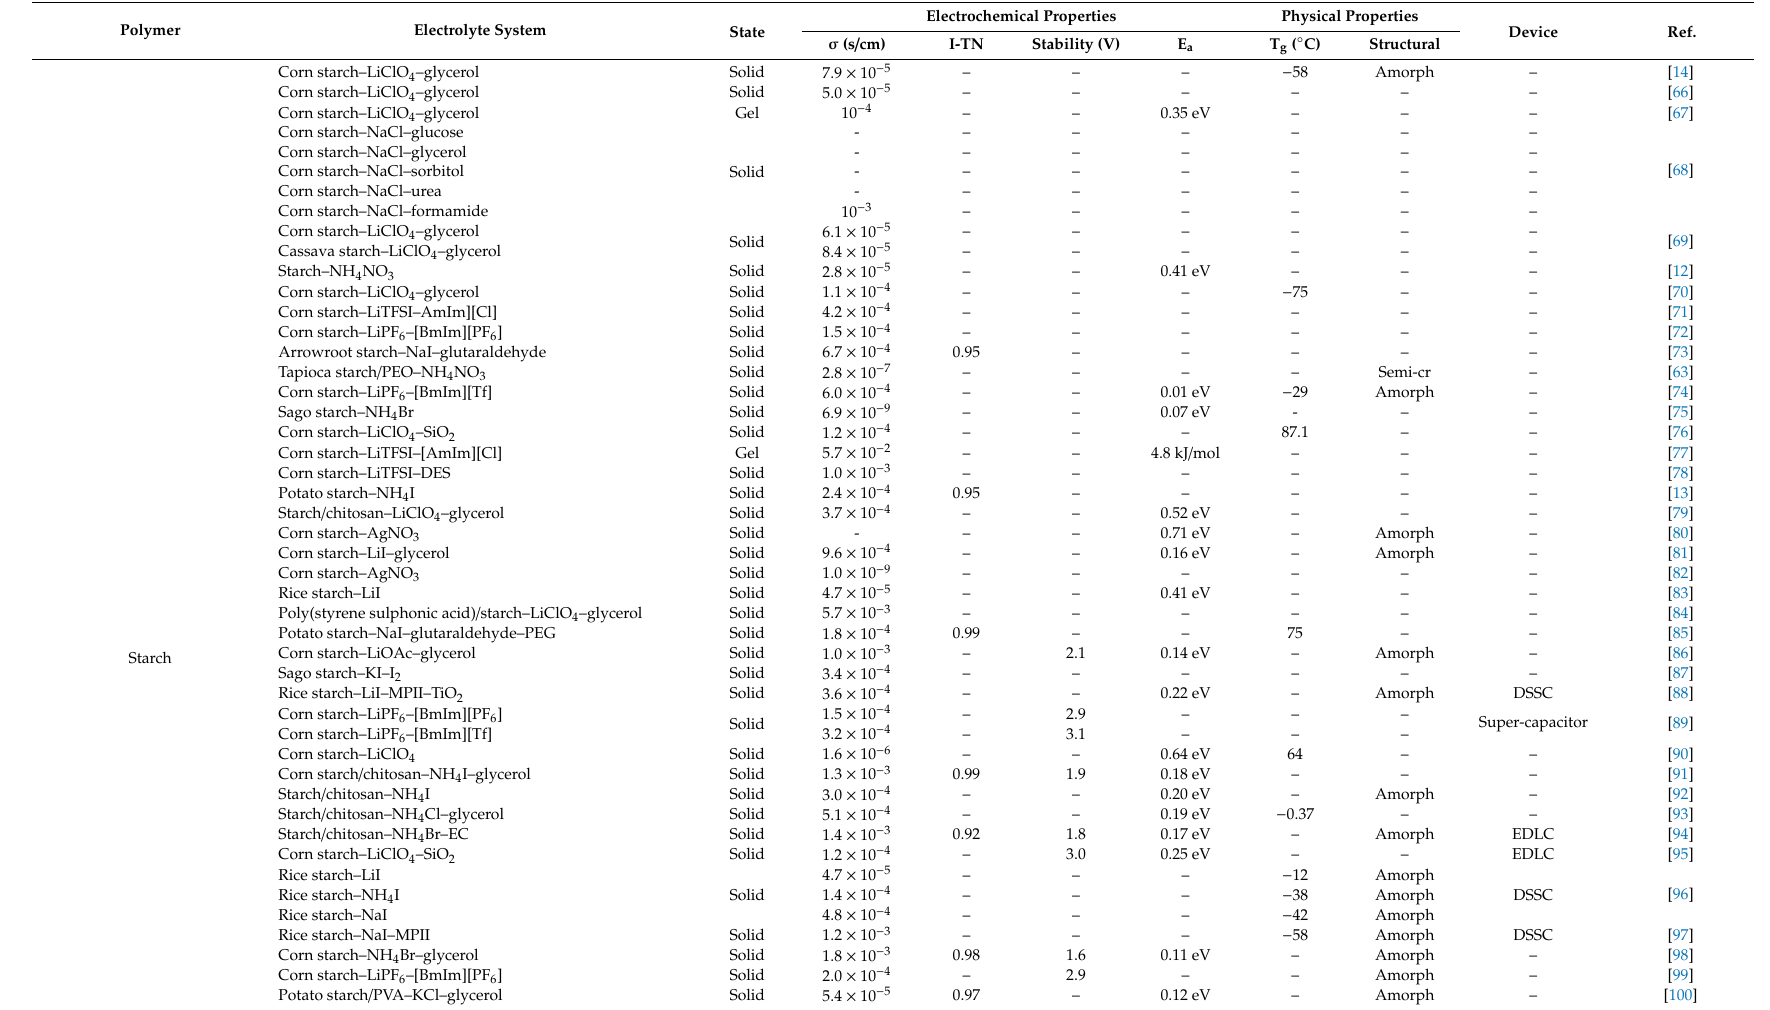
Table 3. Summary of prior study on bio-based polymer